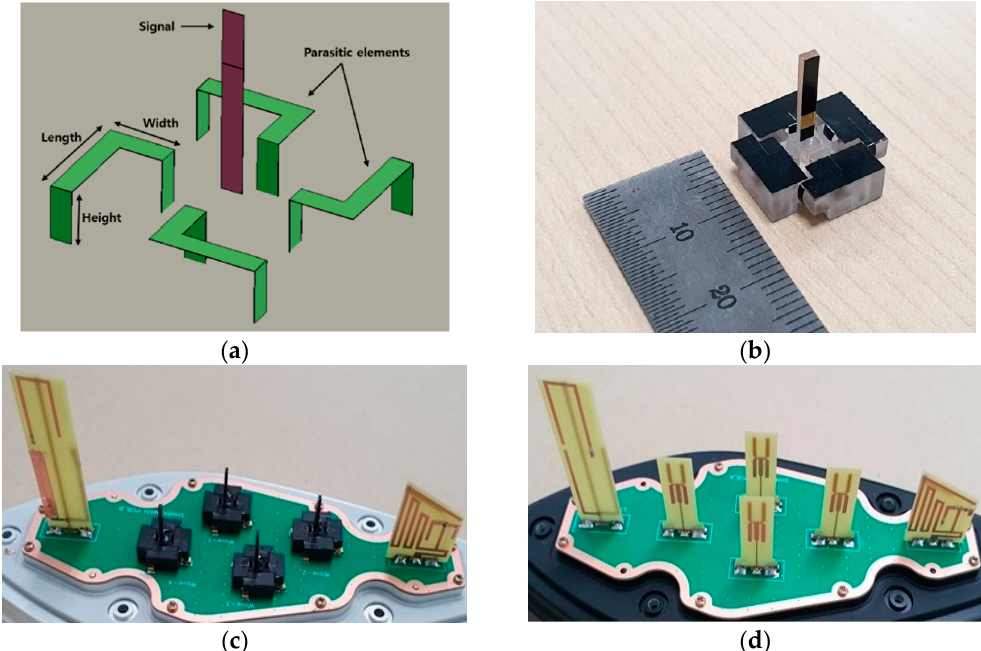
Figure 1. ( a ) Schematic of a closed-loop device; ( b ) Image of the designed monopole WAVE antenna with quadruple closed-loop device; ( c ) Image of the fabricated monopole WAVE antenna with quadruple closed-loop devices installed on the shark-fin module; and ( d ) Monopole-only WAVE antenna, which was used for characterization.